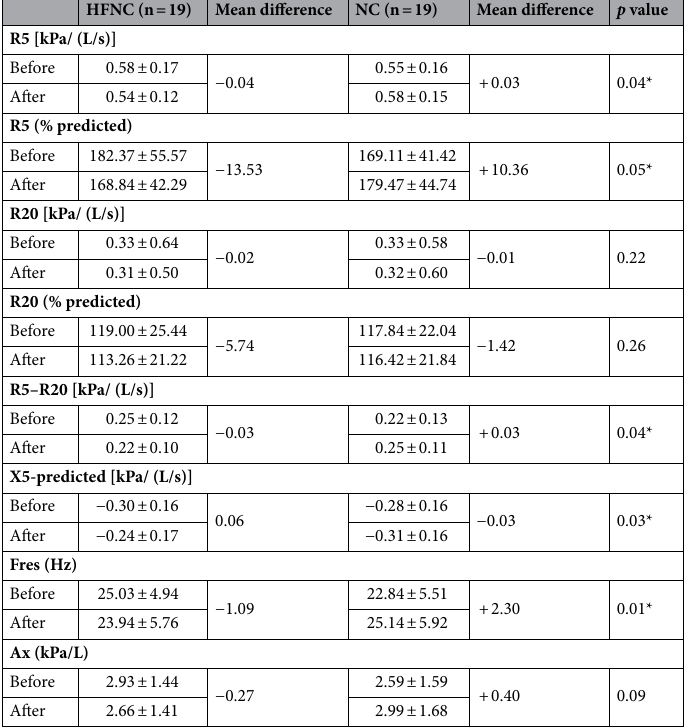
HFNC (n = 19) Mean difference NC (n =